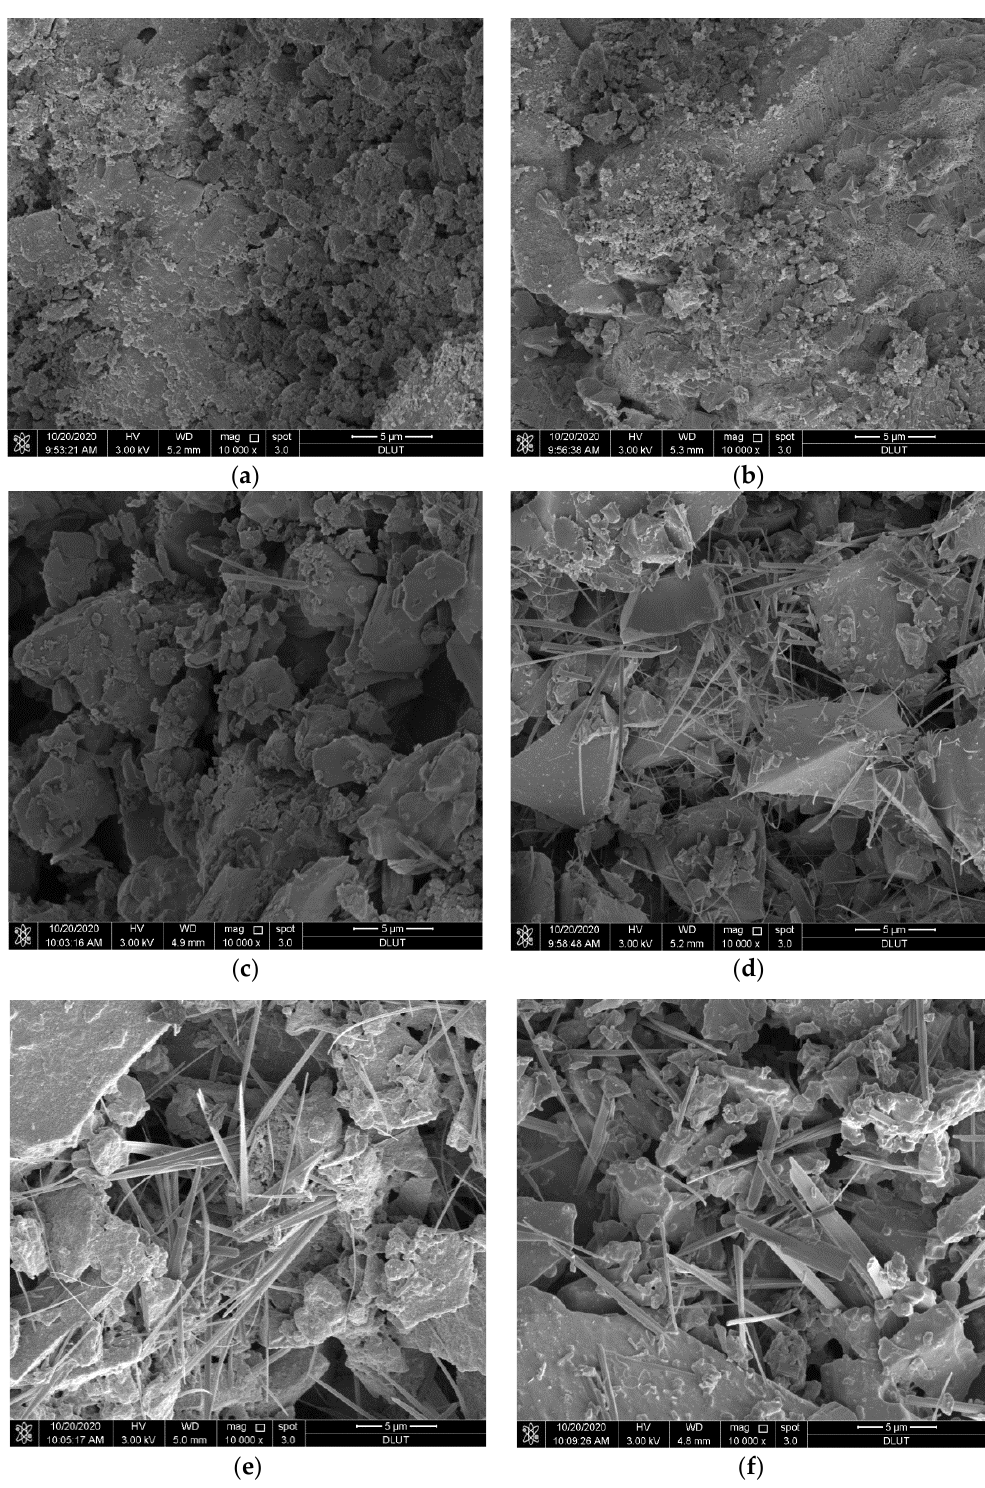
Figure 7. FT − IR spectra of alkali ‐ activated CNS materials after hydration using sodium silicate so ‐ lution with different moduli.